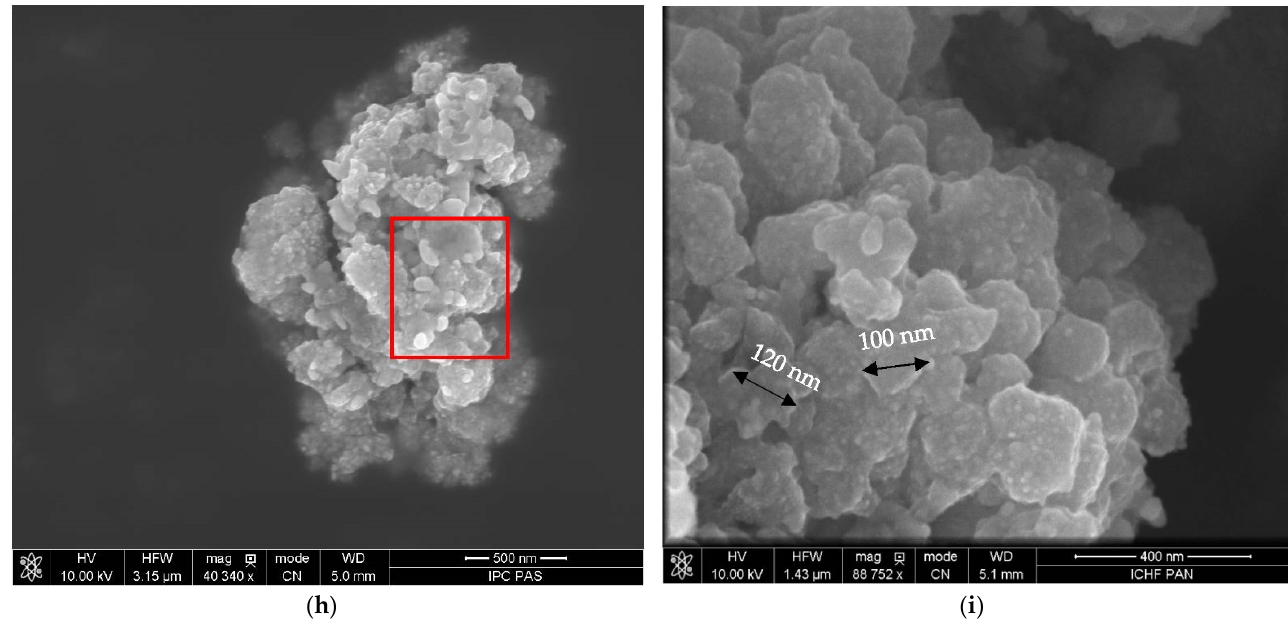
Figure 3. SEM images of nanocomposites synthesized after 120 min using brewery waste BW9 at ( a – c ) 25 ◦ C and ( d , e ) 80 ◦ C, and product B at ( f , g ) 25 ◦ C and ( h , i ) 80 ◦